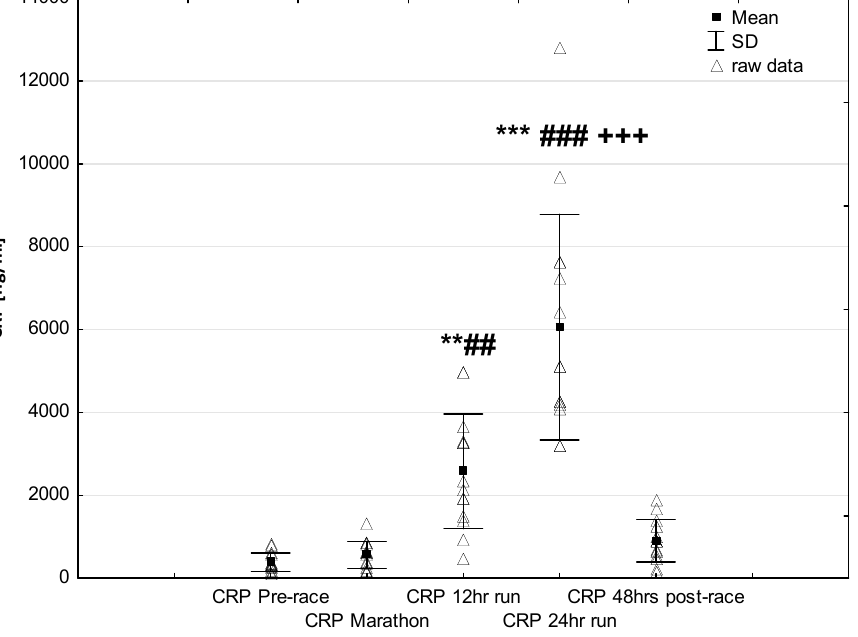
Figure 4. Ultra-marathon-induced changes in serum high sensitive C-reactive protein (hsCRP). ** p < 0.01, *** p < 0.001 versus the corresponding pre-race value (Pre-race); ## p < 0.01, ### p < 0.001 versus the corresponding post-marathon value (Marathon); +++ p < 0.001 versus the corresponding post 12-h run value (12-h run).